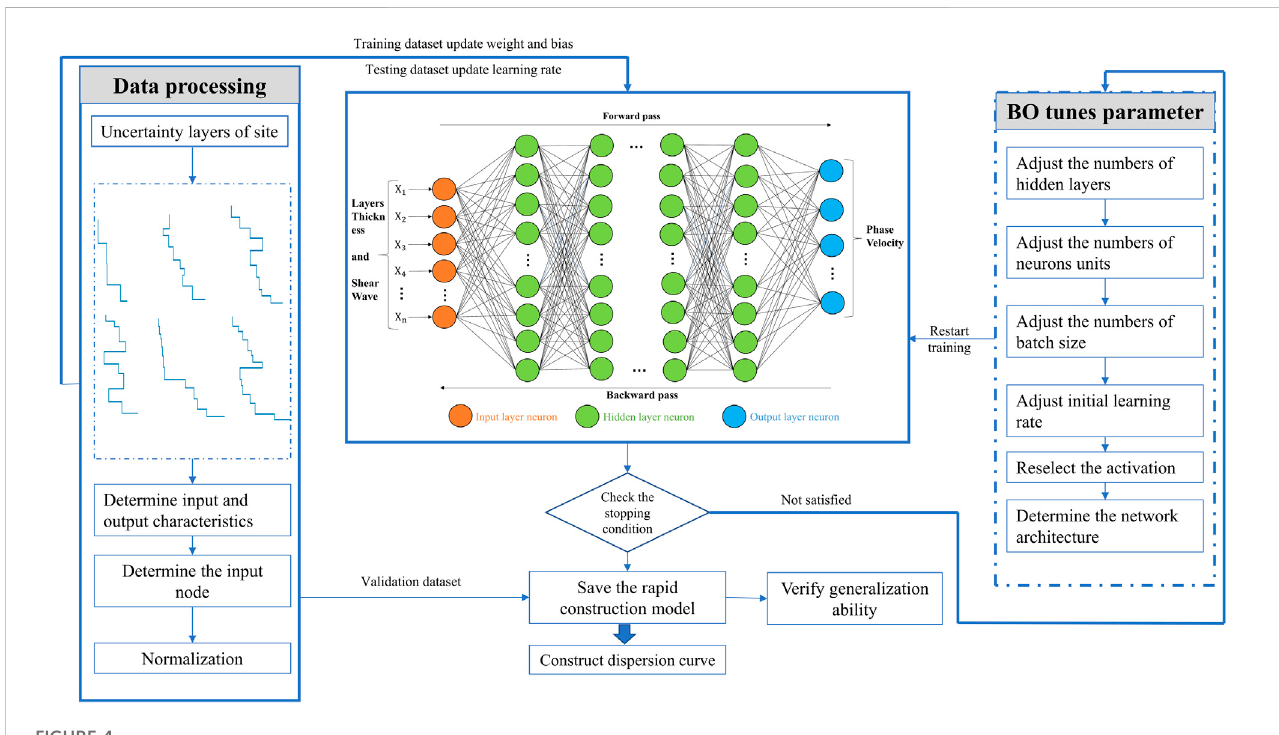
FIGURE 4 Model building fl ow